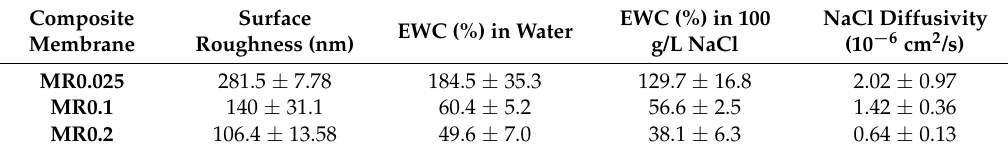
Table 2. Characterization results of composite PVA/PVDF membrane (Diffusivity of NaCl in pure water is 14.7 × 10 − 6 cm 2 /s). MR: Molar Ratio. EWC: Equilibrium Water